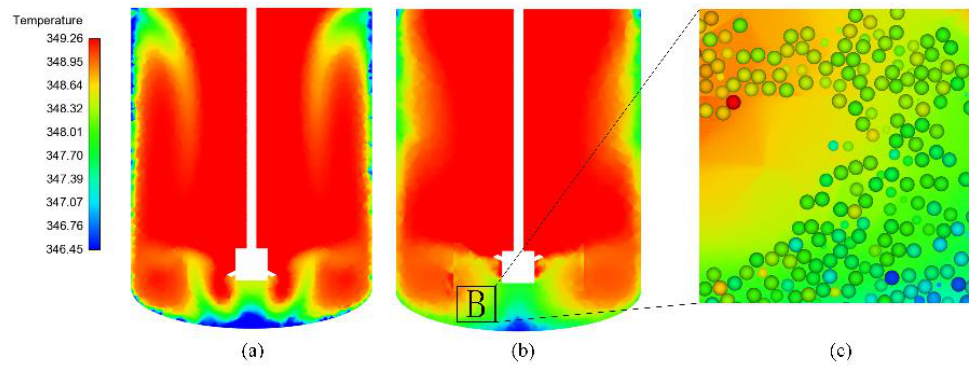
Figure 9. The temperature on XZ plane of ( a ) the tank with single-phase flow and ( b ) the tank with particle flow. ( c ) Amplified temperature distribution of fluid and particles in region B. t = 1 s.